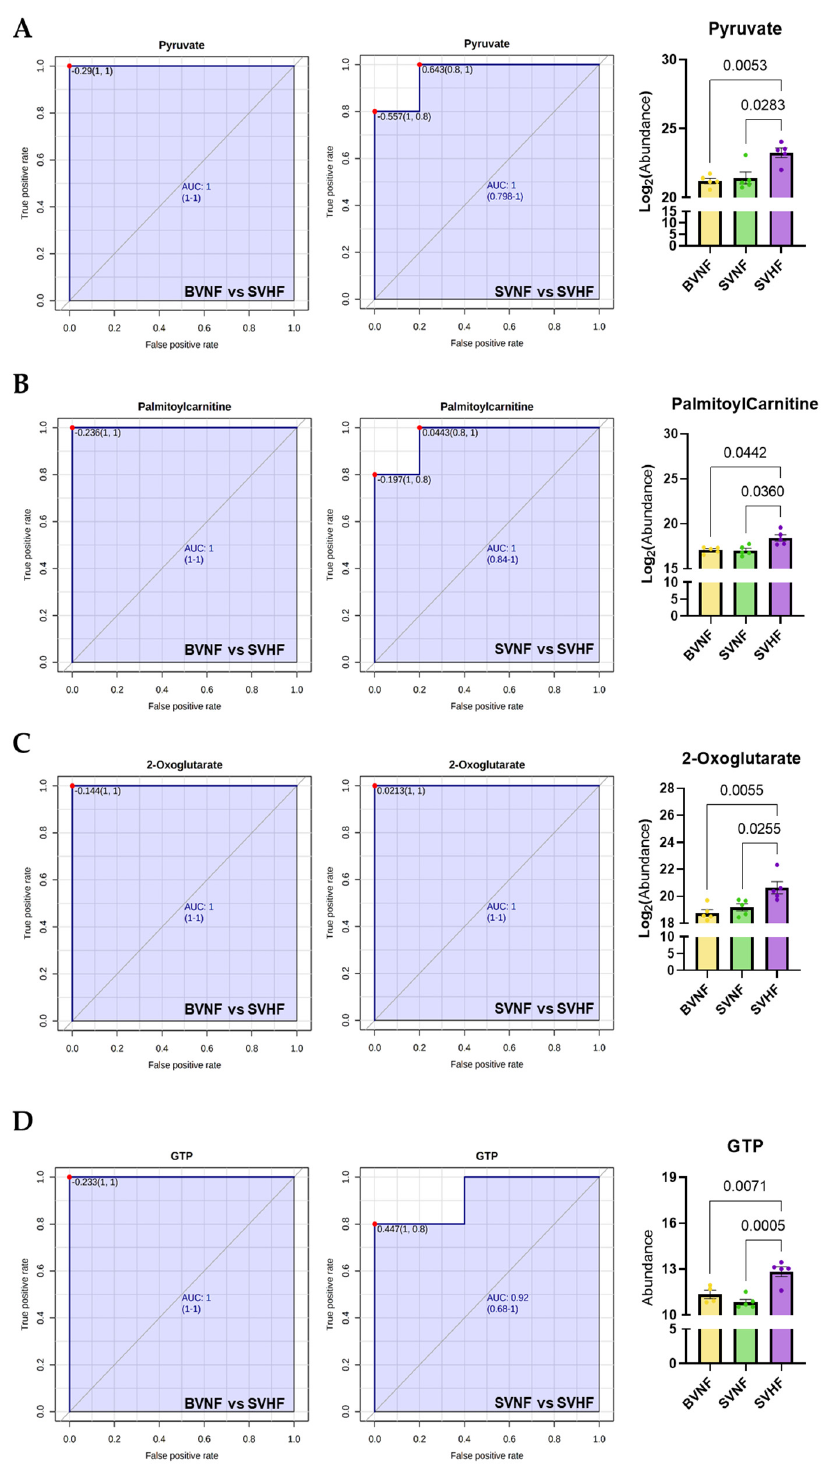
Figure 8. Univariate analysis-based diagnostic potential of individual metabolites to distinguish BVNF from SVHF or SVNF from SVHF. ( A – D ) univariate ROC curves demonstrating the AUC and 95% confidence interval (CI) and bar graphs demonstrating metabolite abundance for each of the top scoring specific metabolites. ( A ) Pyruvate. ( B ) Palmitoylcarnitine. ( C ) 2-Oxoglutarate. ( D ) GTP. For all groups, bar equals mean ± SEM; each point represents individual patient values ( n = 5 BVNF, n = 5 SVNF and n = 5 SVHF subjects); p -values as indicated based on a one-way ANOVA (Welch’s) and Tukey’s multiple comparison test.